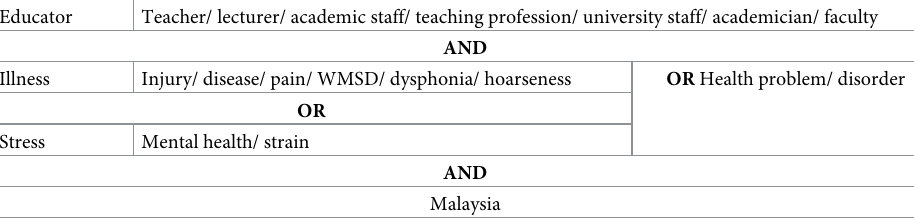
Table 1. Keywords used for the literature